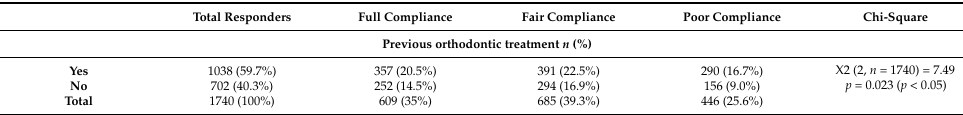
Table 5. Patient compliance and previous orthodontic